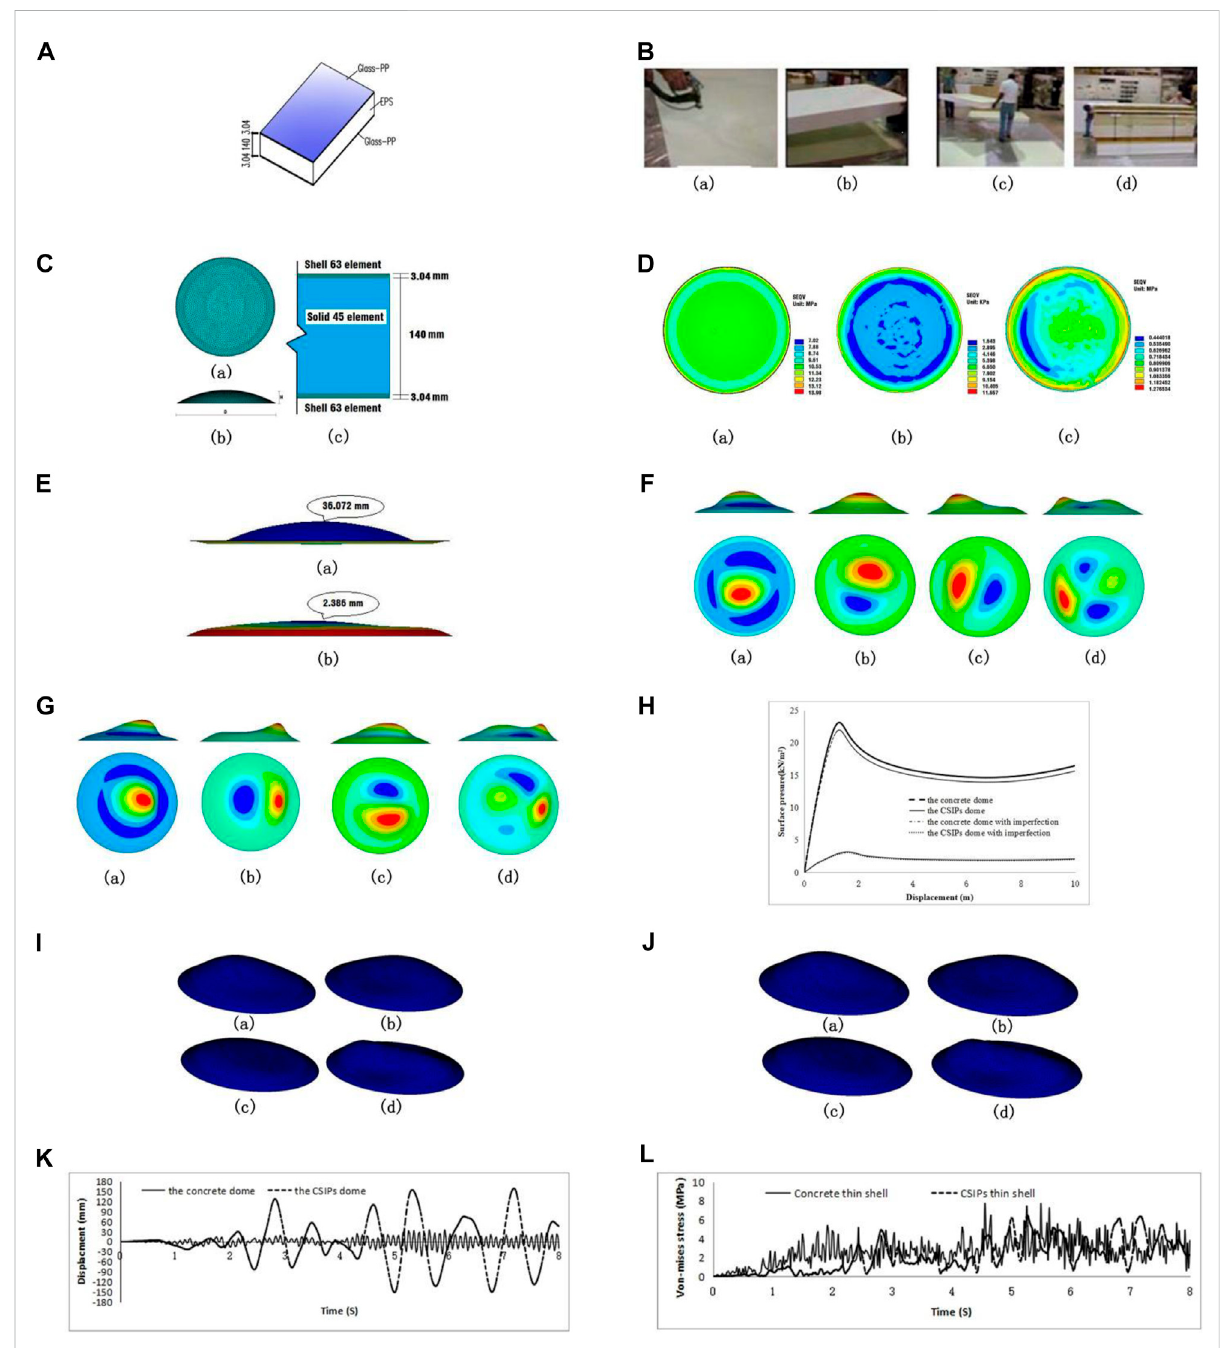
FIGURE 1 (A) SchematicdiagramofCSIPs(unit:mm); (B) ManufacturingofCSIPs:(a)sprayinghot-meltadhesivebondingagent;(b)placingthefoamcore on the lower panel sheet; (3) making a piece of completed CSIP; (d) storing the fabricated CSIPs panels; (C) Structural parameters of the fi nite elementmodelofCSIPsdome:(a)plan;(b)elevation;(c)cross-section; (D) Von-Misesstress:(a)GFRPofCSIPsdome;(b)EPSofCSIPsdome(c)thin- shellconcretedome; (E) Verticaldisplacements:(a)verticaldisplacementofCSIPsdome;(b)verticaldisplacementofthin-shellconcretedome; (F) Top 4 buckling mode shapes of CSIPs dome: (a) fi rst order; (b) second order; (c) third order; (d) fourth order; (G) Top 4 buckling mode shapes of thin-shell concrete dome: (a) fi rst order; (b) second order; (c) third order; (d) fourth order; (H) Vertical displacement versus load curve at the center point; (I) Mode shapes and frequencies of CSIPs dome: (a) fi rst order, f = 1. 1,033; (b) second order, f = 1.1064; (c) third order, f = 1.1307. (d) fourth order, f = 1.5323; (J) Mode shape and frequencies of thin-shell concrete dome: (a) fi rst order, f = 12.065; (b) second order, f = 12,141; (c) third order, f=12.680;(d)fourthorder,f=16.503; (K) Time-displacementcurveofcenterpointunderEL-Centroseismicwave; (L) Time-stresscurveofelement with Maximum Von-mises stress under EL-Centro seismic